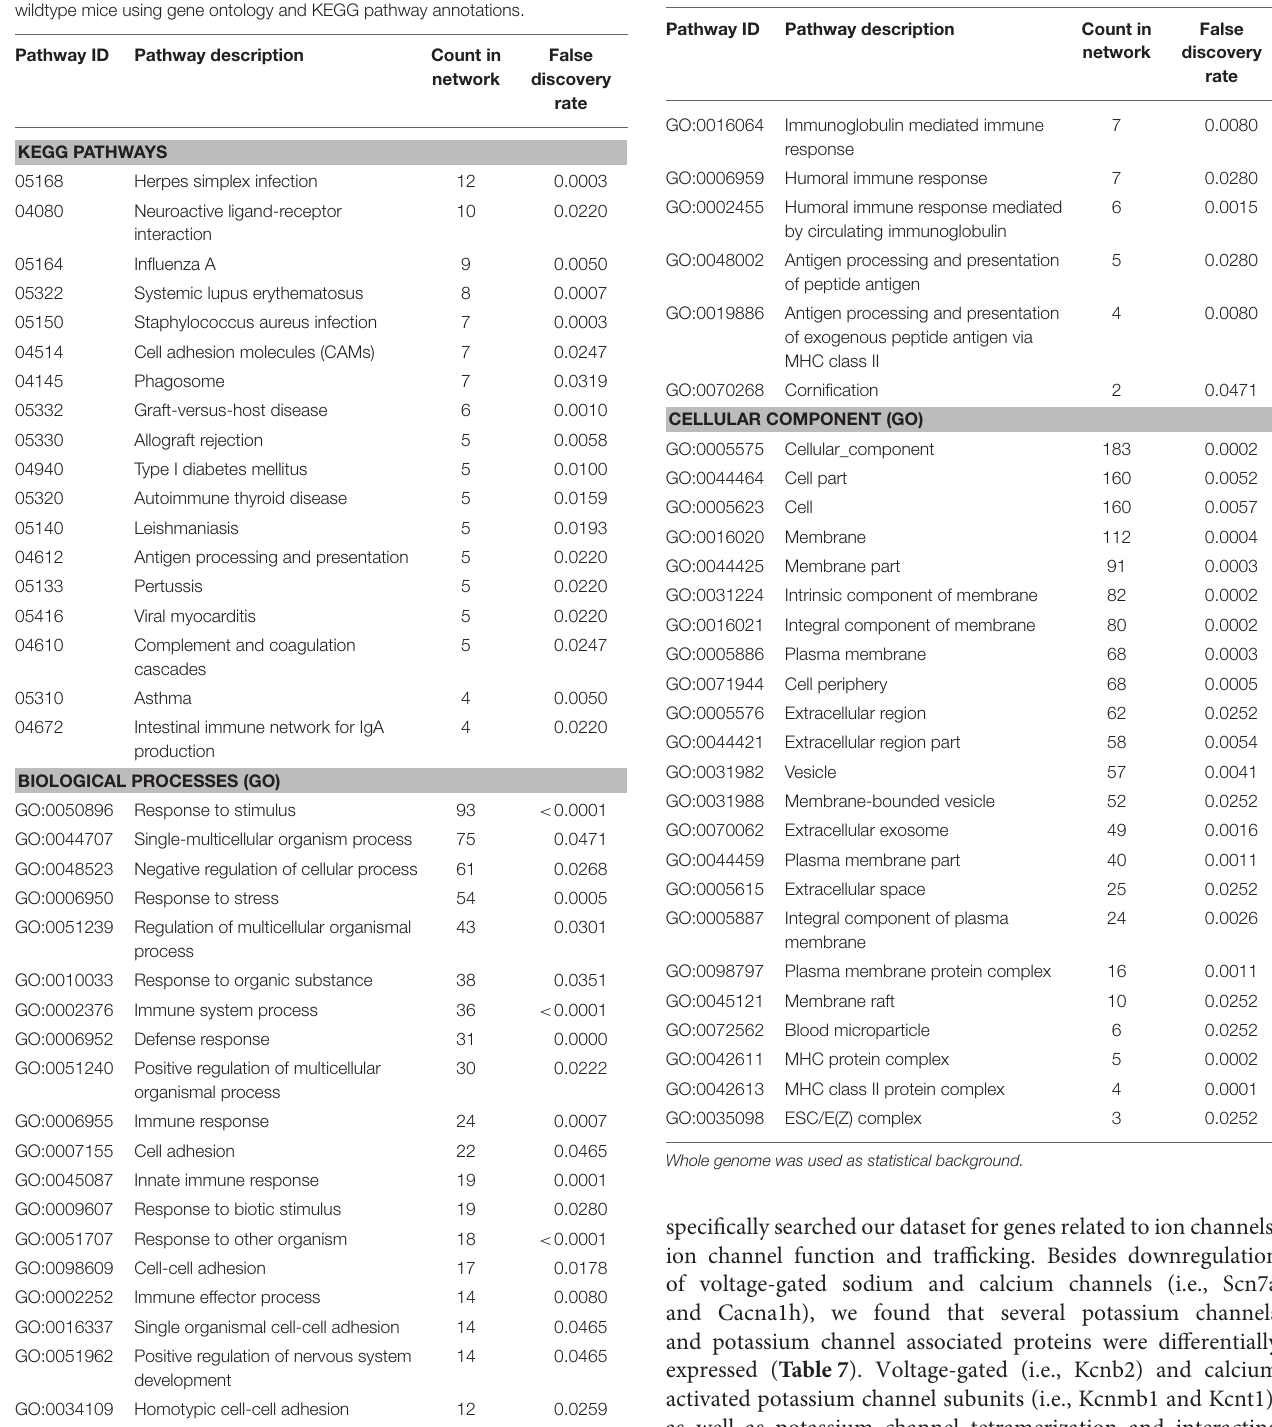
TABLE 5 | Enrichment-analysis for downregulated mRNAs in α -Gal A ( − / 0) vs. wildtype mice using gene ontology and KEGG pathway annotations. Pathway ID Pathway description